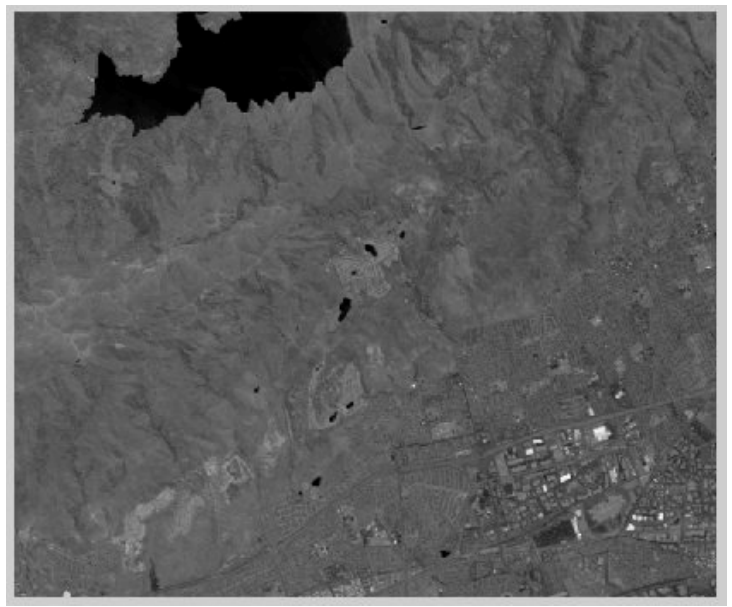
Figure 1 . (top) Broadband image of a scene A, which is cluttered because it includes mountains, buildings, and water, but to our knowledge contains no